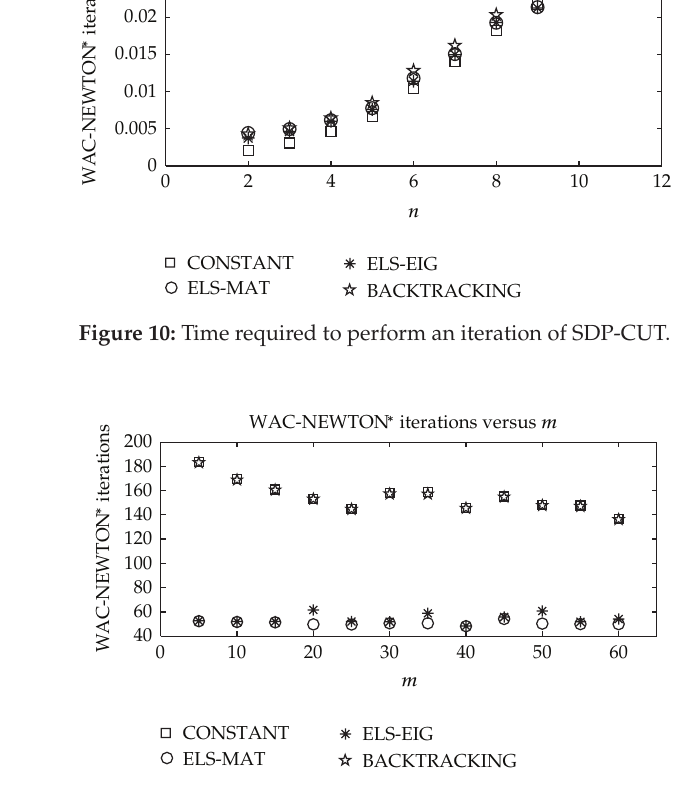
Figure 11: SDP-CUT iterations with matrix